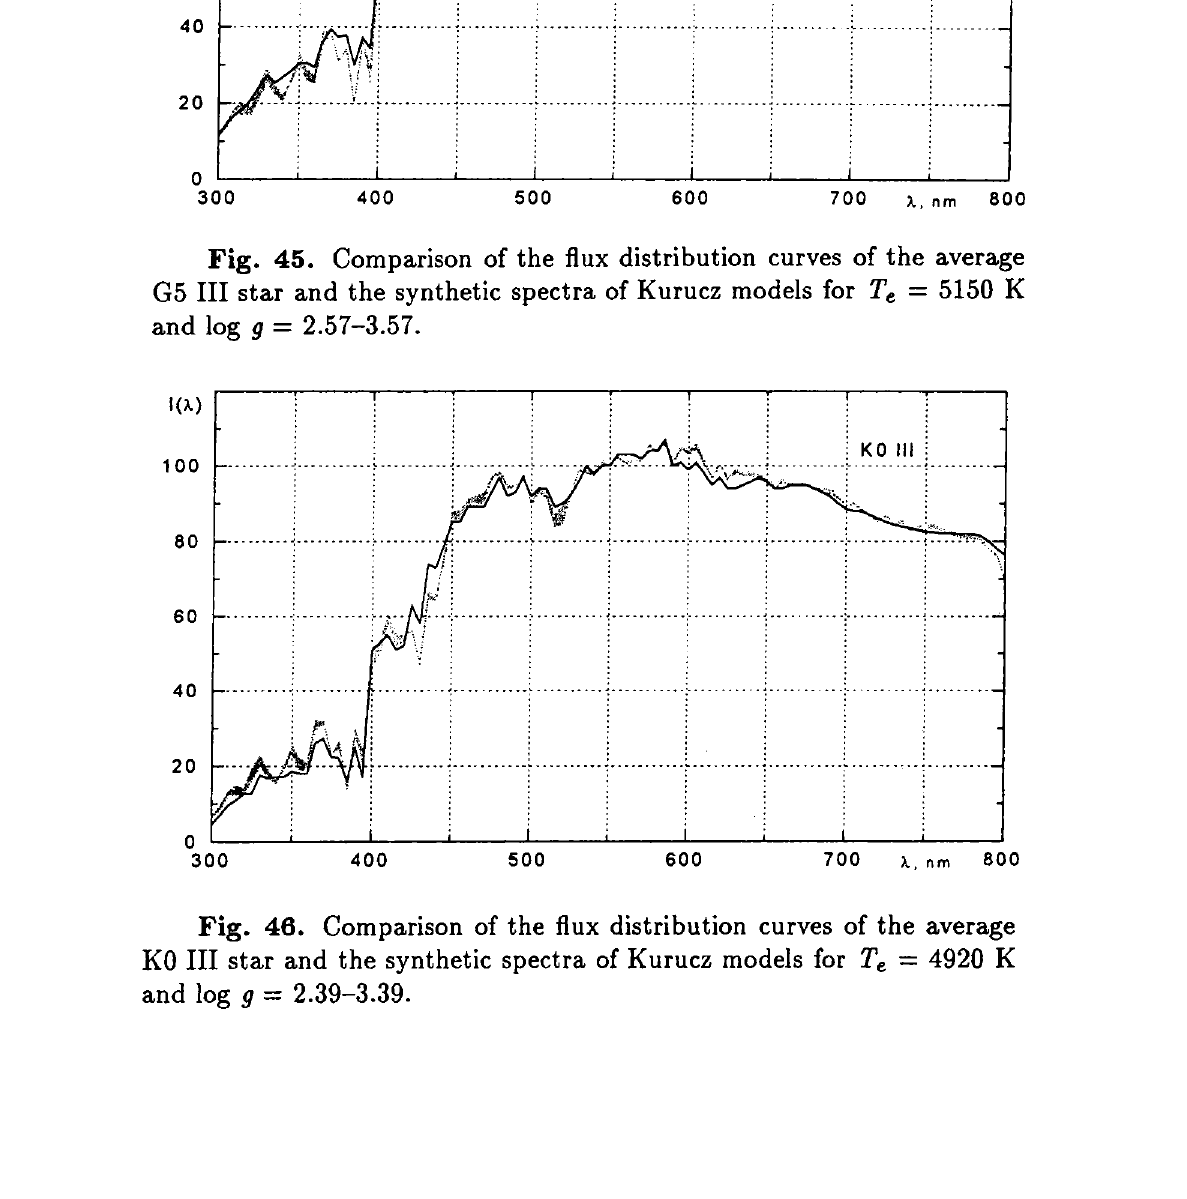
Fig. 45. Comparison of the flux distribution curves of the average G5 III star and the synthetic spectra of Kurucz models for T e = 5150 K and log g = 2.57-3.57.